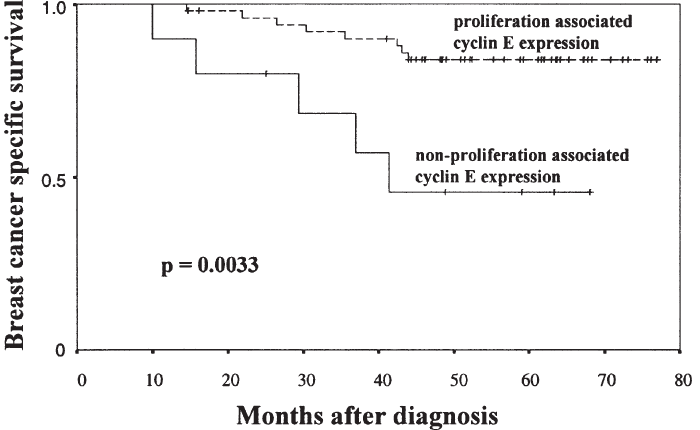
Fig. 6. Kaplan–Meier plots of breast cancer specific survival in 65 patients with stage I–III disease for the two tumour groups defined in Fig. 5. analysis with covariates showing prognostic significance in the univariate analysis, high cyclin E expres- sion defined by Western blotting were a significant prognostic factor ( p = 0 : 022) whereas high fraction of Ki-67 positive cells or elevated non proliferation associated cyclin E expression were not significant factors ( p = 0 : 209 and p = 0 :